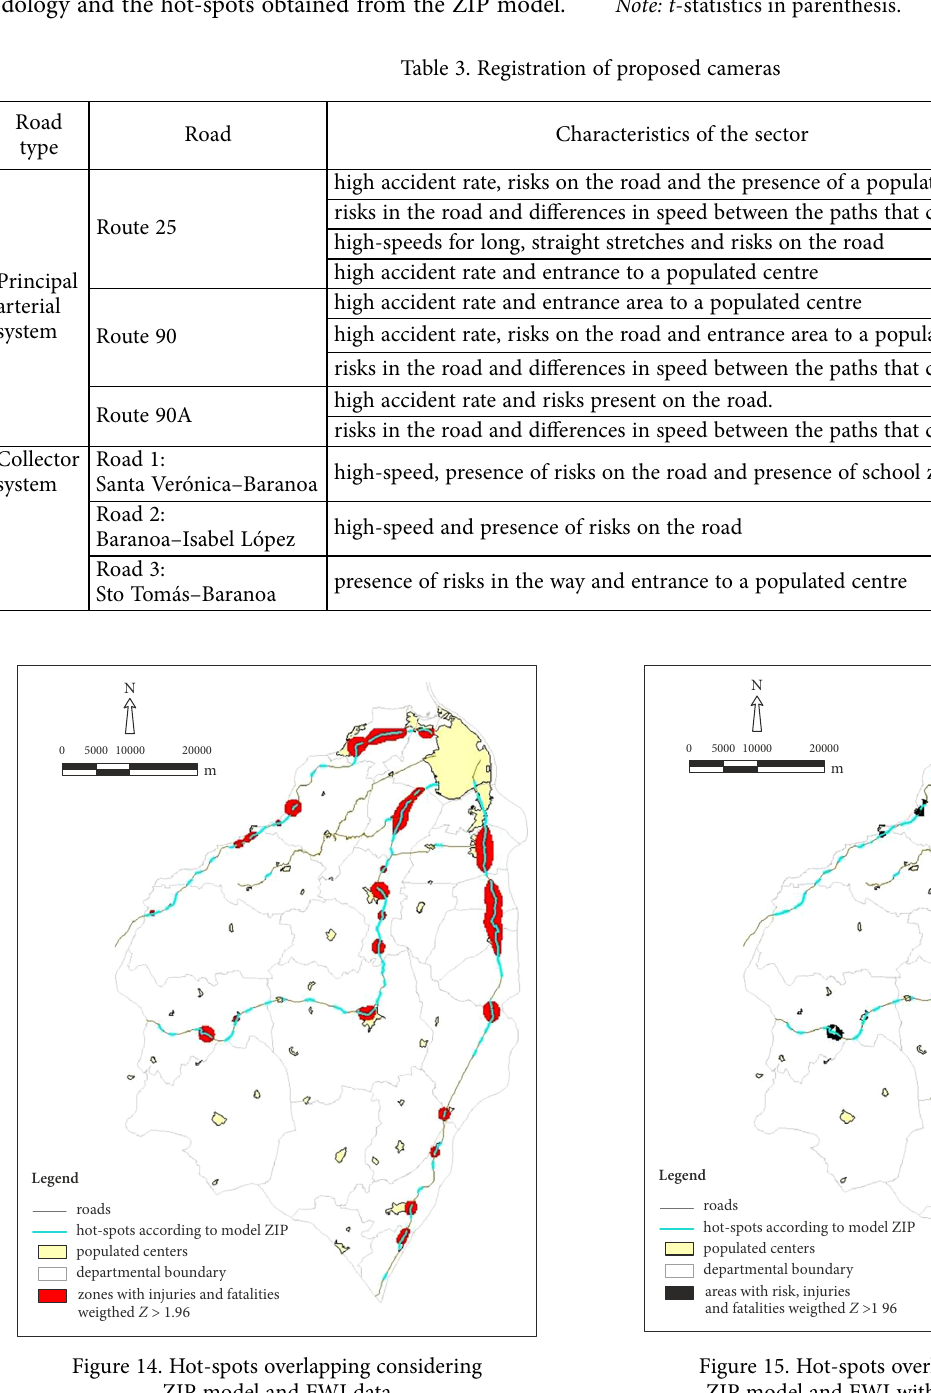
Figure 14. Hot-spots overlapping considering ZIP model and FWI data